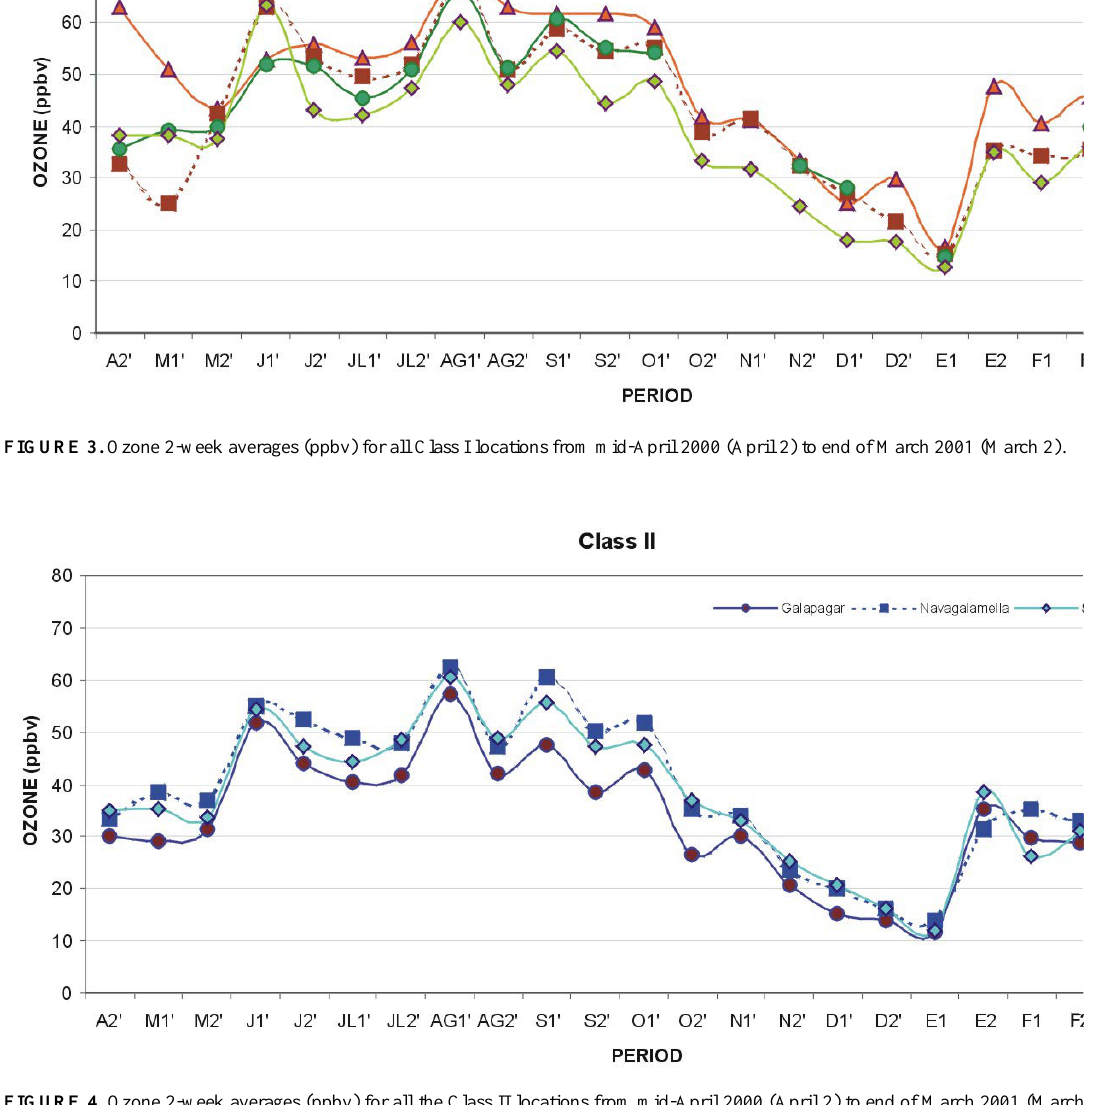
FIGURE 4. Ozone 2-week averages (ppbv) for all the Class II locations from mid-April 2000 (April 2) to end of March 2001 (March